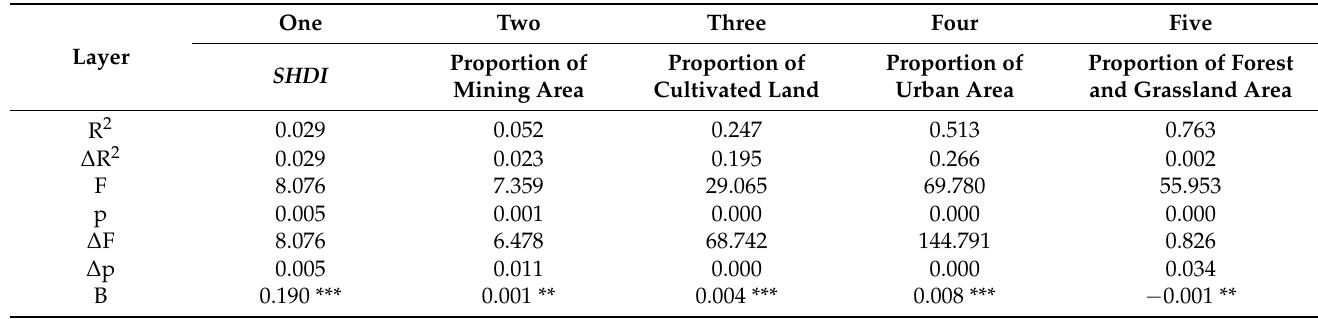
Table 6. The results of hierarchical multiple regression of ecological